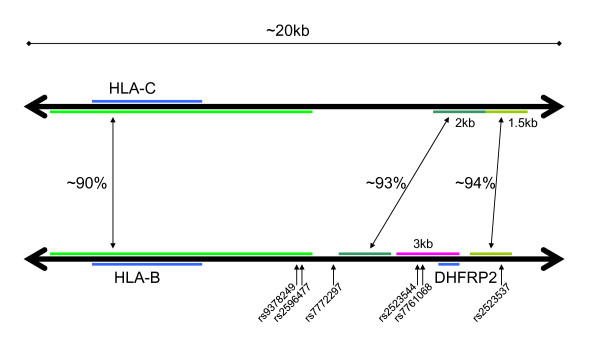
The structure of the homology between the HLA-B and HLA-C containing duplicons on chromosome 6. Genes and pseudogenes are shown in blue. Corresponding homologous regions are shown in matching shades of green, together with the degree of homology according to the segmental duplication track of the UCSC browser (the two rightmost segments) or Blast (the leftmost segment). The pink region is about 91% homologous to the DHFR region on chromosome 5.